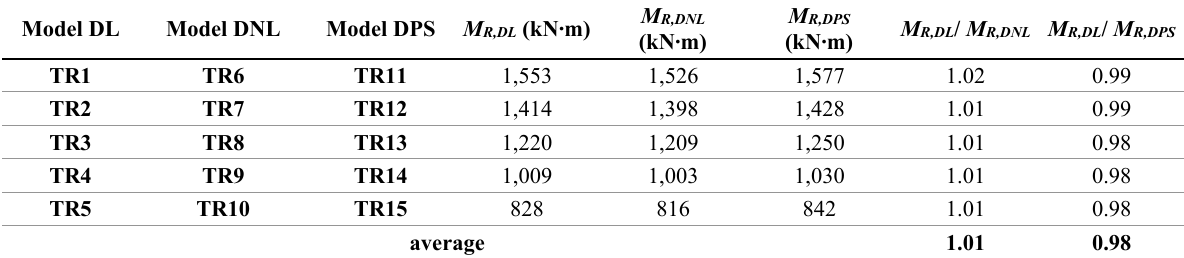
Table 2. Numerical results obtained for residual stress